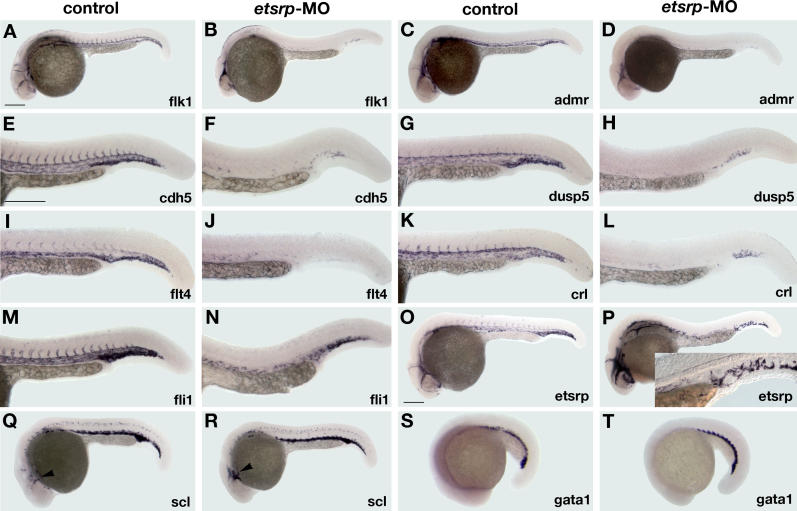
Molecular Analysis of Vascular Endothelial and Hematopoietic Markers in etsrp Morphants(A, C, E, G, I, K, M, O, Q, S) Uninjected control embryo; (D, H, J, L, P, R, T) 8 ng etsrp MO2-injected embryo; (B, F, N) 12 ng etsrp MO1+MO2 (1:1) mix-injected embryos for the maximum knockdown. All embryos are at 24 hpf, except as noted. Scale bar, 0.2 mm. (A,B) flk1 expression; (C,D) admr expression; (E,F) cdh5 expression; (G,H) dusp5 expression; (I,J) flt4 expression; (K,L) crl expression. Note that the vascular expression of the markers in (A–L) is almost absent in etsrp morphants. (M,N) fli1 expression; (O,P) etsrp expression. Note the more intense etsrp expression and reduced fli1 expression in angioblasts which remain dispersed and fail to coalesce into blood vessels in etsrp morphants. Inset, (P) DIC image of scattered angioblasts in etsrp morphants. (Q,R) scl expression, 22 hpf. Note that scl expression appears unaffected at this stage except for more intense staining in a subset of head vessels in etsrp morphants (arrowhead). (S,T) gata1 expression, 22 somites. Note that no significant difference in hematopoietic gata1 expression is observed between the control embryos and etsrp morphants.